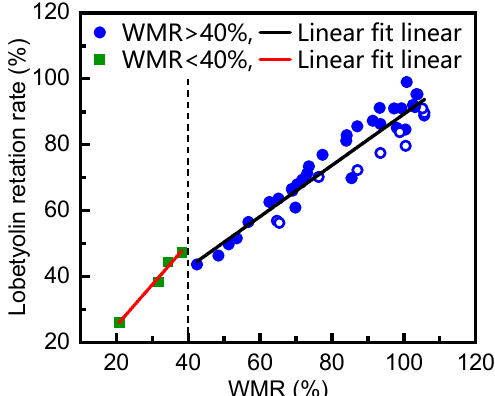
represents the data from (cid:35)